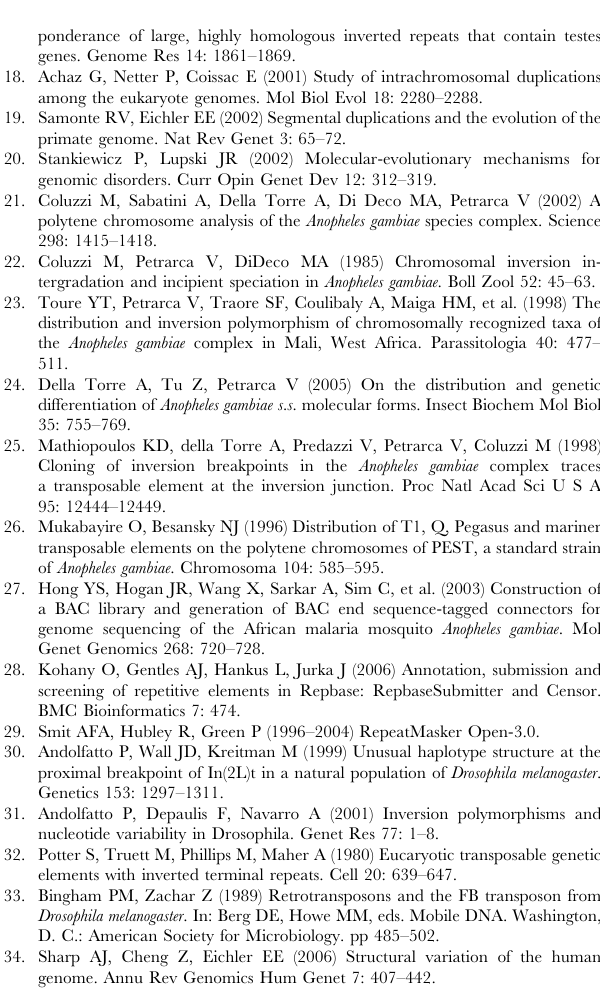
Table S1 CENSOR results of known transposons and retro-